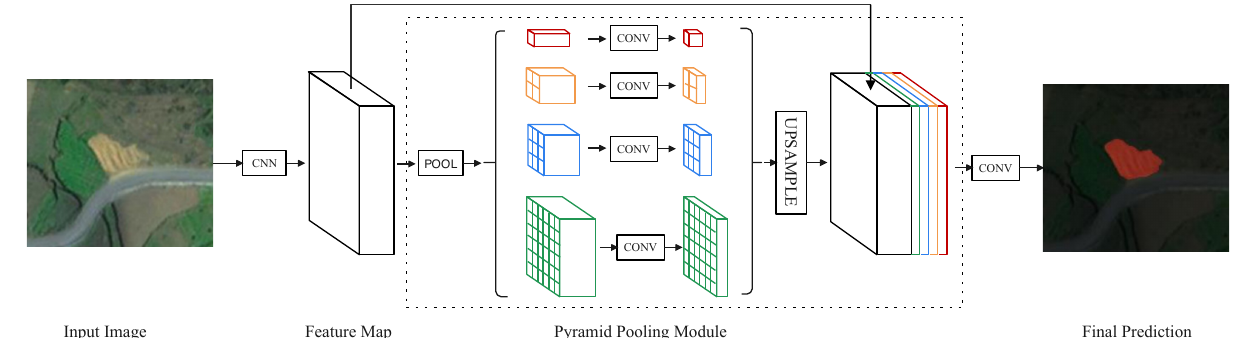
Figure 3. PSPNet architecture. First, a CNN is used to obtain the last convolutional feature map given an input image. A pyramid parsing module is then applied to collect different subregion repre- sentations, followed by upsampling and concatenation layers to form the final feature representation.